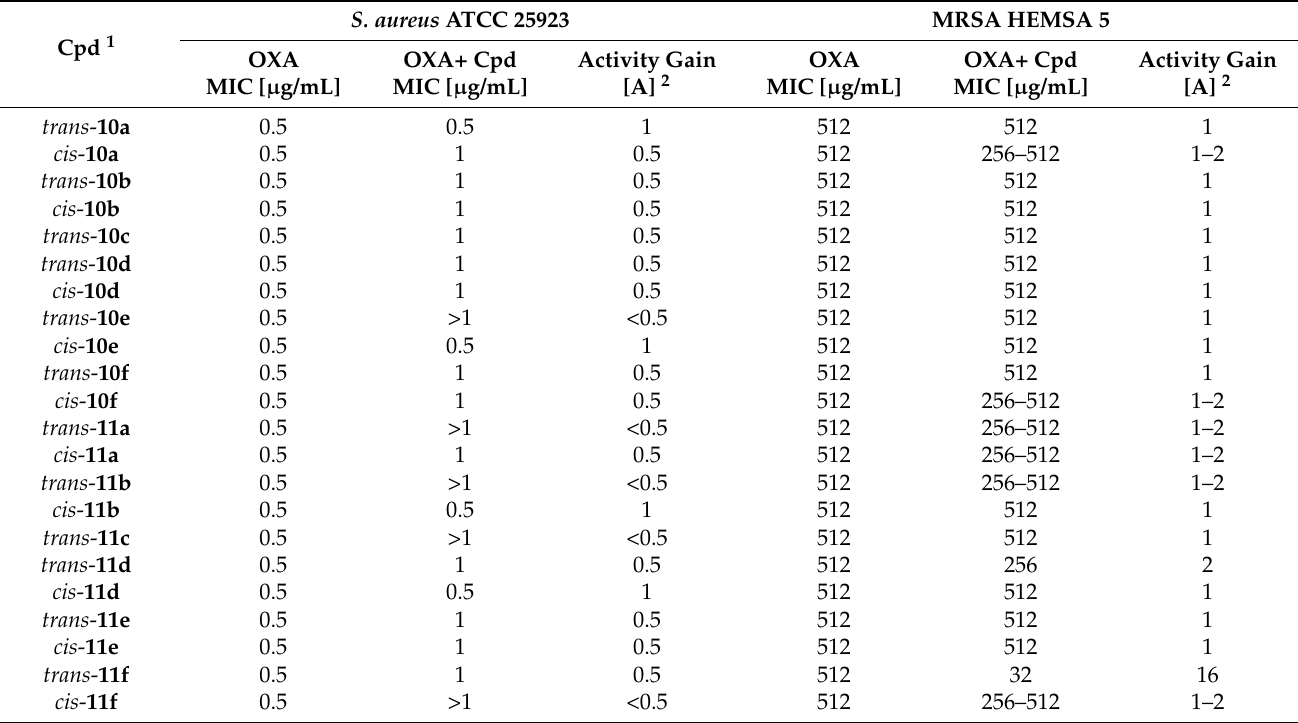
Table 3. The ability of azetidinone compounds to enhance antibacterial activity of oxacillin against S. aureus ATCC 25923 and S. aureus MRSA HEMSA